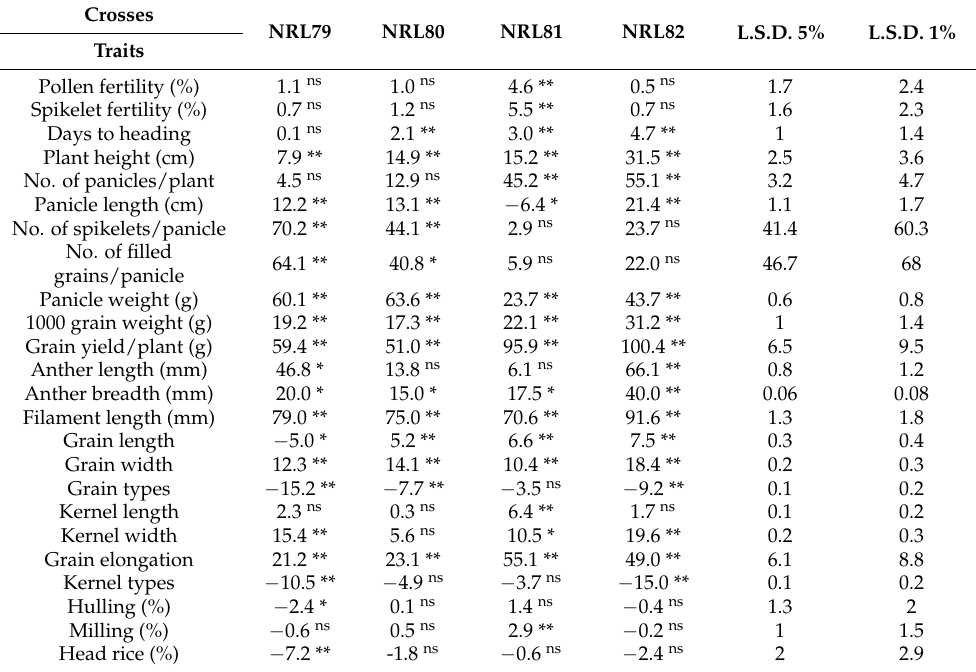
Table 2. Percentage of advantage over commercial variety for the grain yield, yield contributing traits, floral traits, and grain quality traits of promising restorer lines of